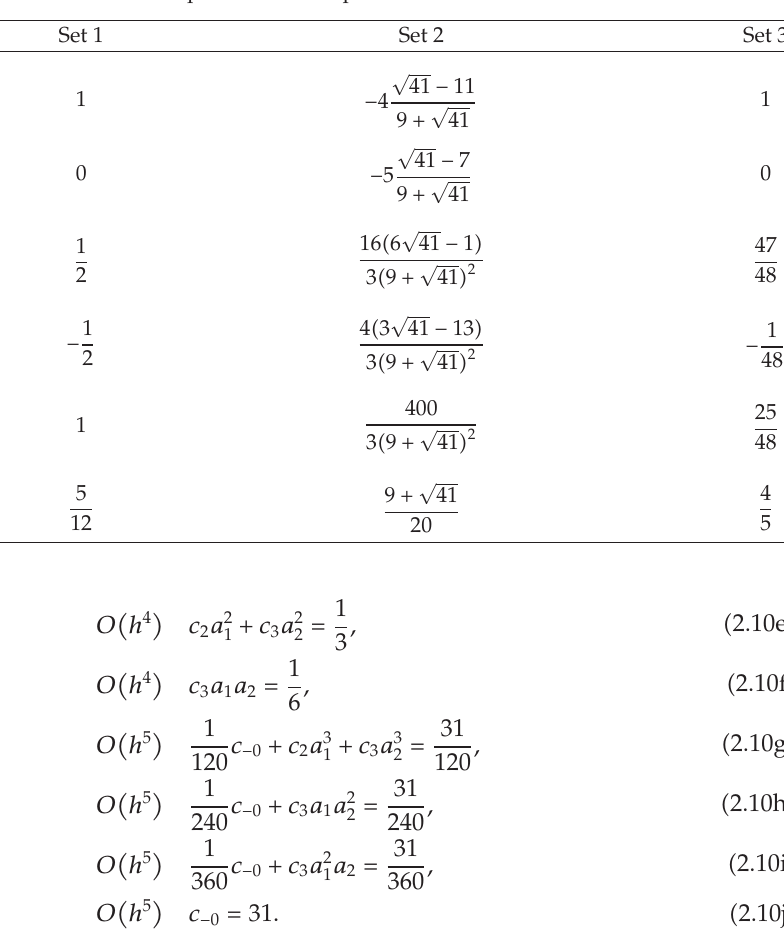
Table 1: Optimized ARK3 parameter